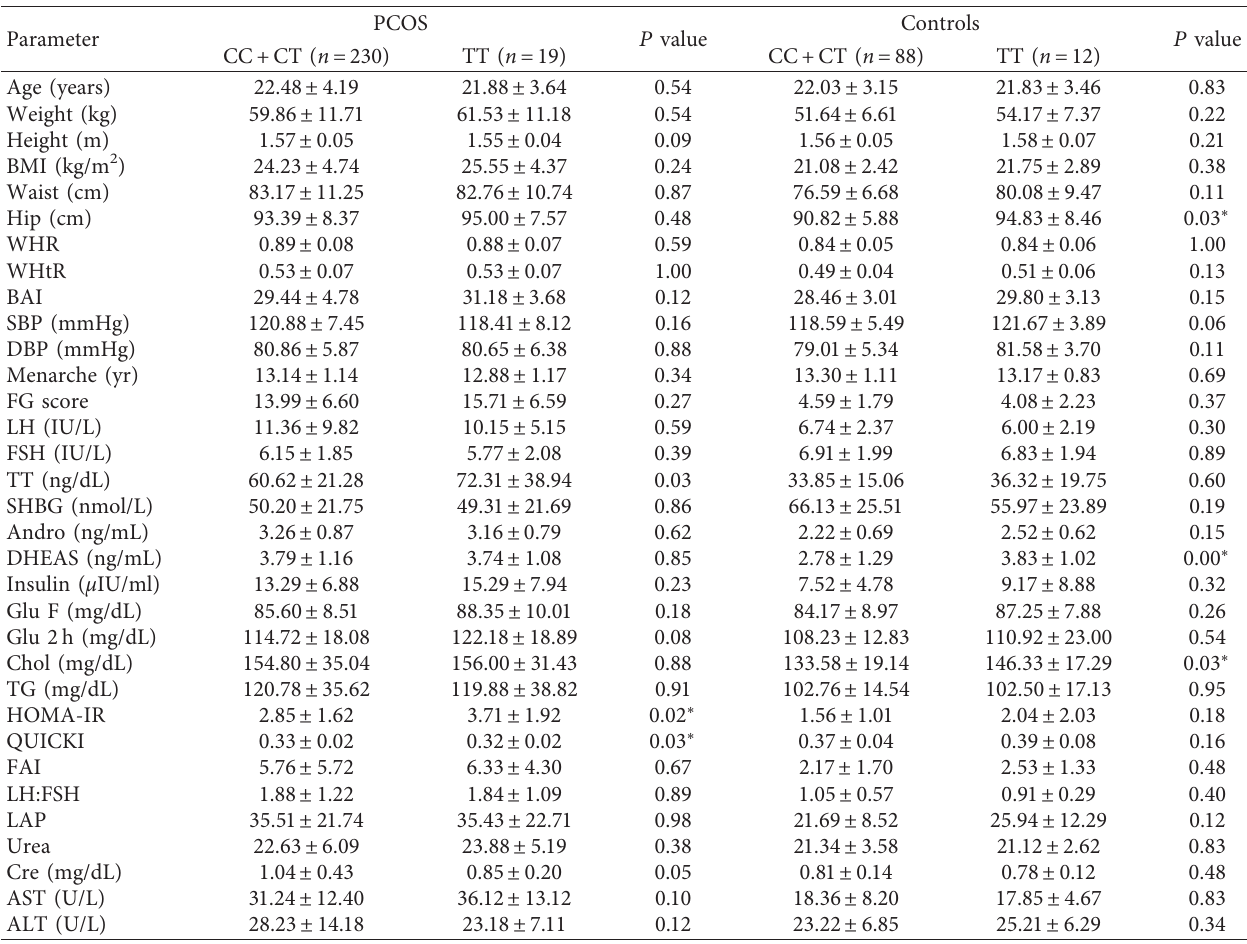
Table 2: Comparison of anthropometric, clinical, hormonal, metabolic, and biochemical parameters in dominant genotype model for INSR rs1799817 SNP in PCOS